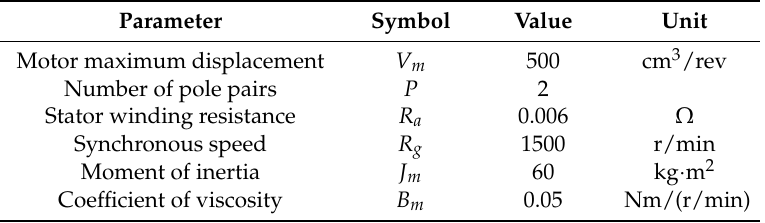
Table 3. Main parameters of hydraulic motor and synchronous